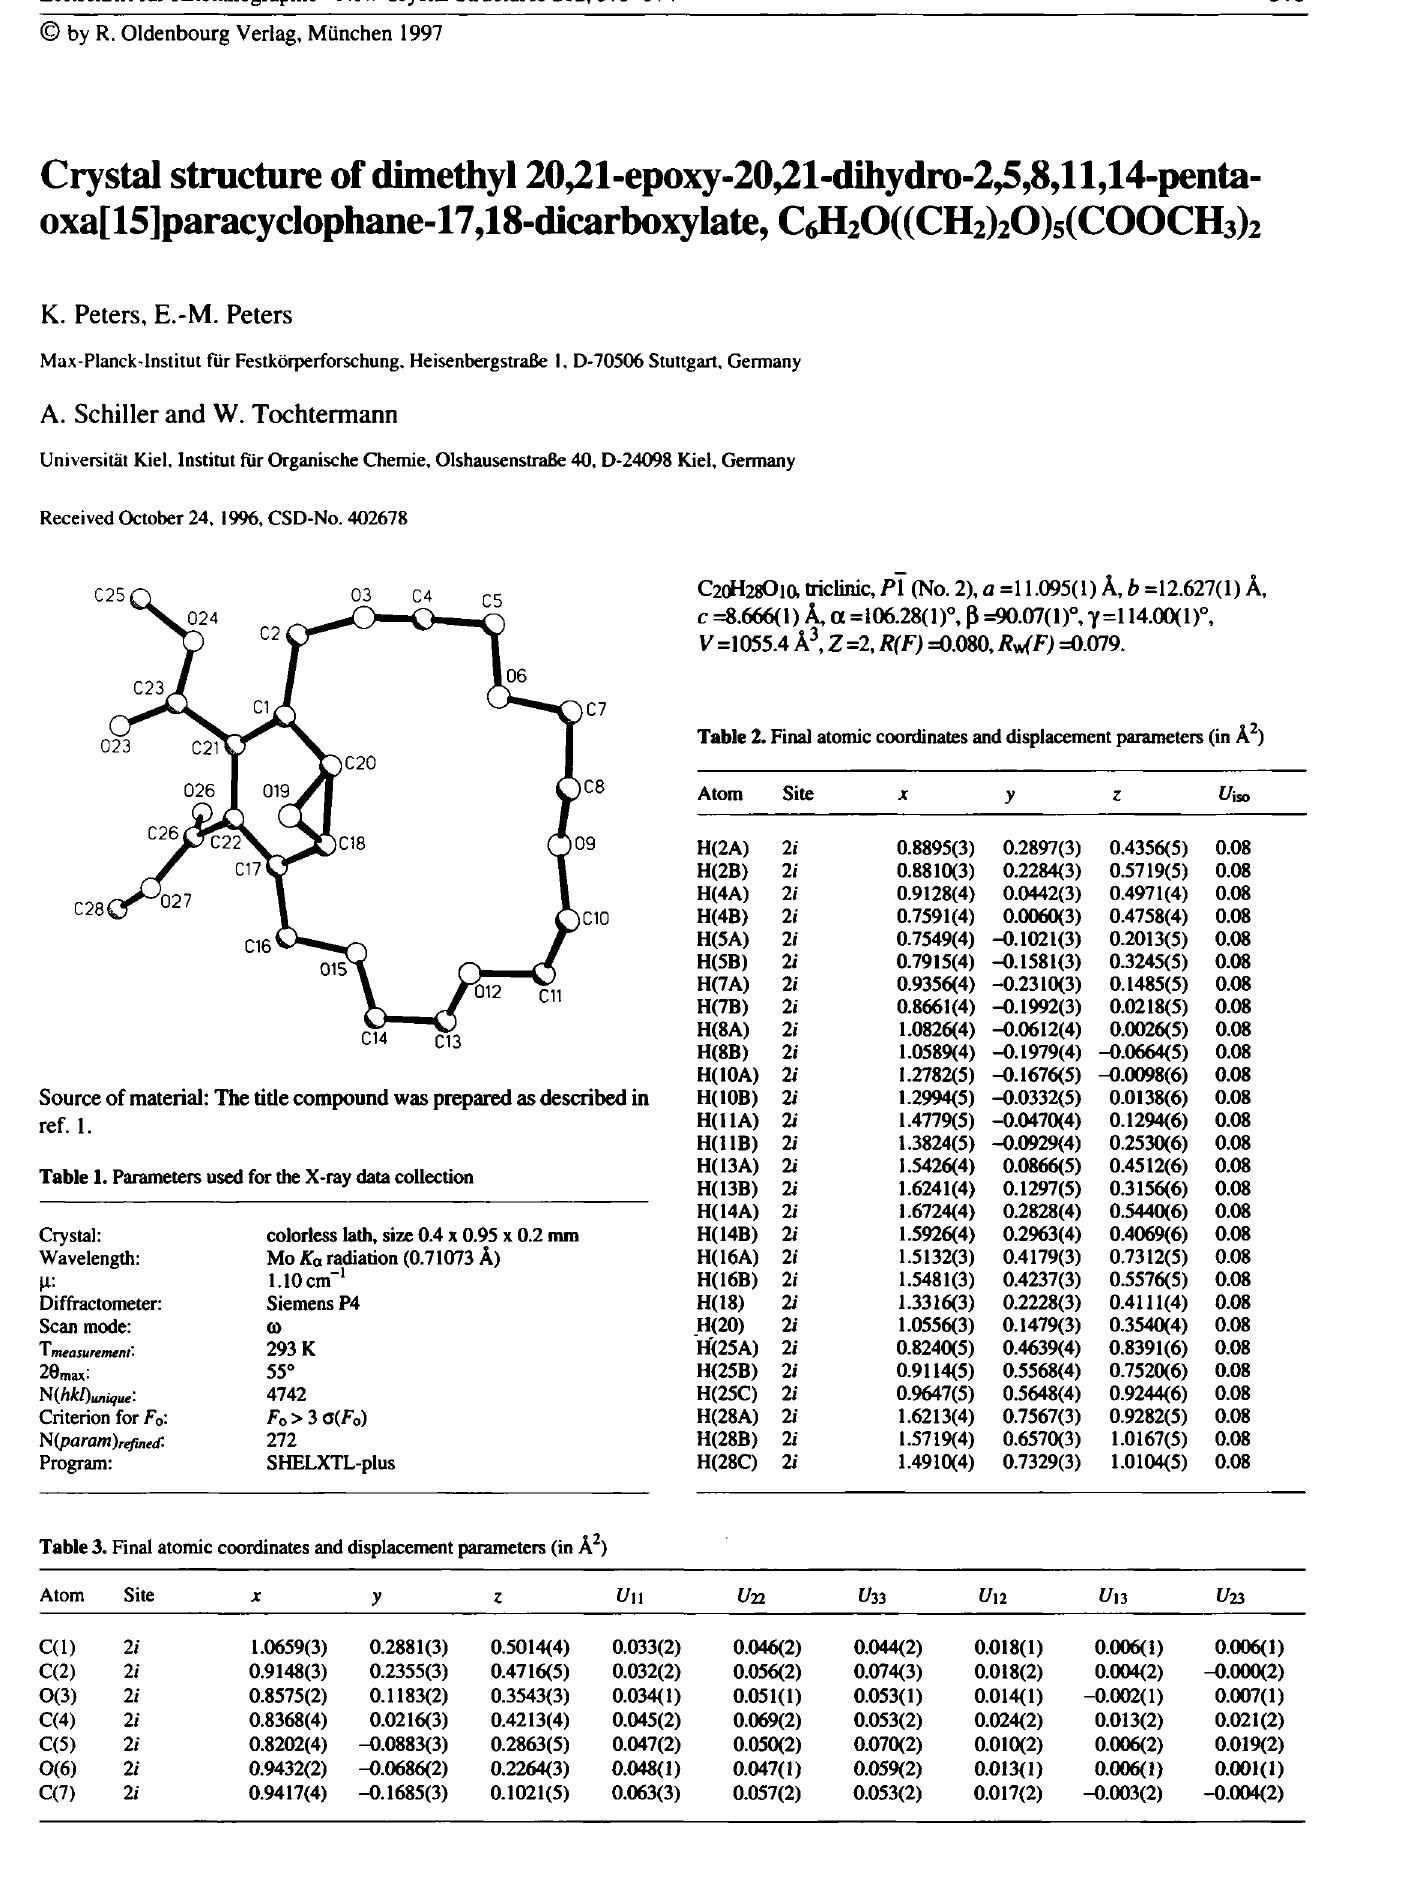
Table 3. Final atomic coordinates and displacement parameters (in Â 2 ) Atom